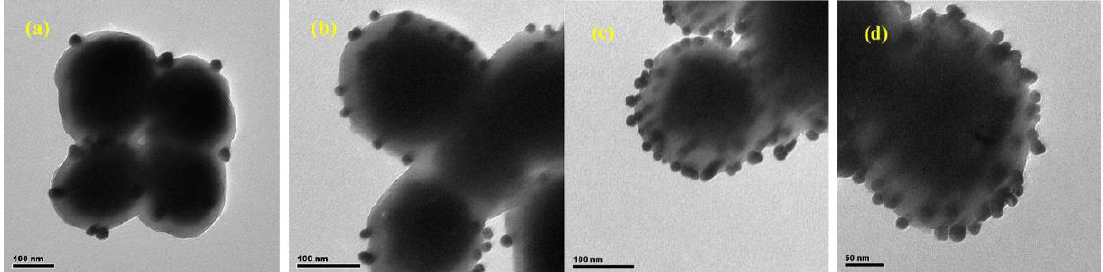
Figure 10. TEM images of ( a ) Fe 3 O 4 @PTA@Ag-1, ( b ) Fe 3 O 4 @PTA@Ag-2, ( c ) Fe 3 O 4 @PTA@Ag-3, and ( d ) Fe 3 O 4 @PTA@Ag-4 (adapted with permission from reference [79].